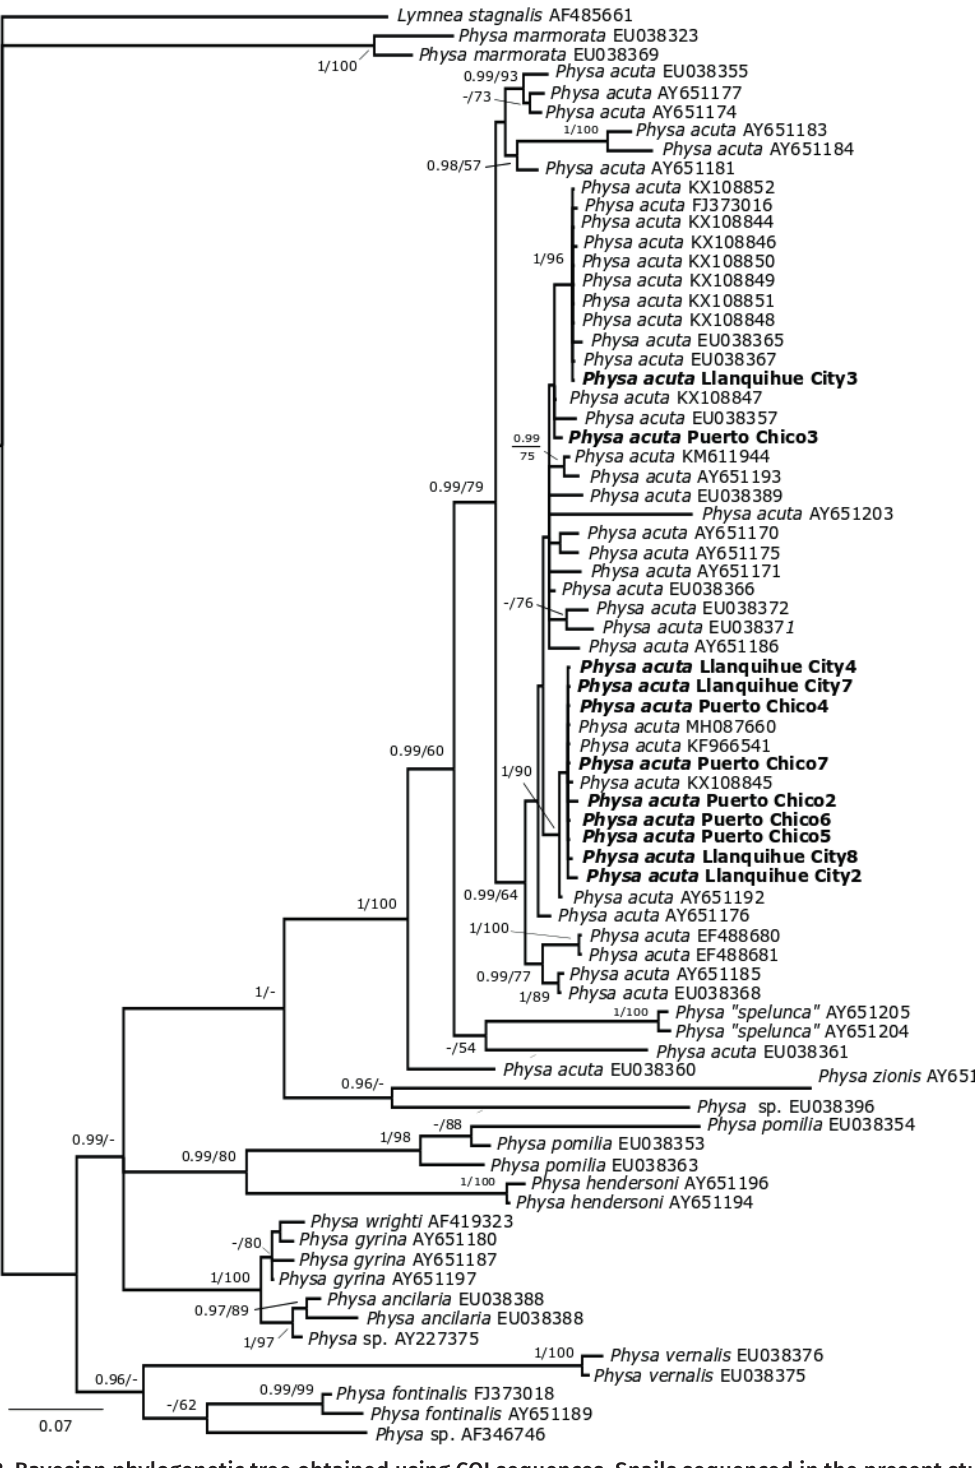
Figure 3. Bayesian phylogenetic tree obtained using COI sequences. Snails sequenced in the present study are depicted in bold. Numbers above the nodes indicate posterior probability values obtained in the BI analysis (only values equal to or greater than 0.95 are given) followed by the bootstrap values obtained in the MP analysis (only values above 50% are